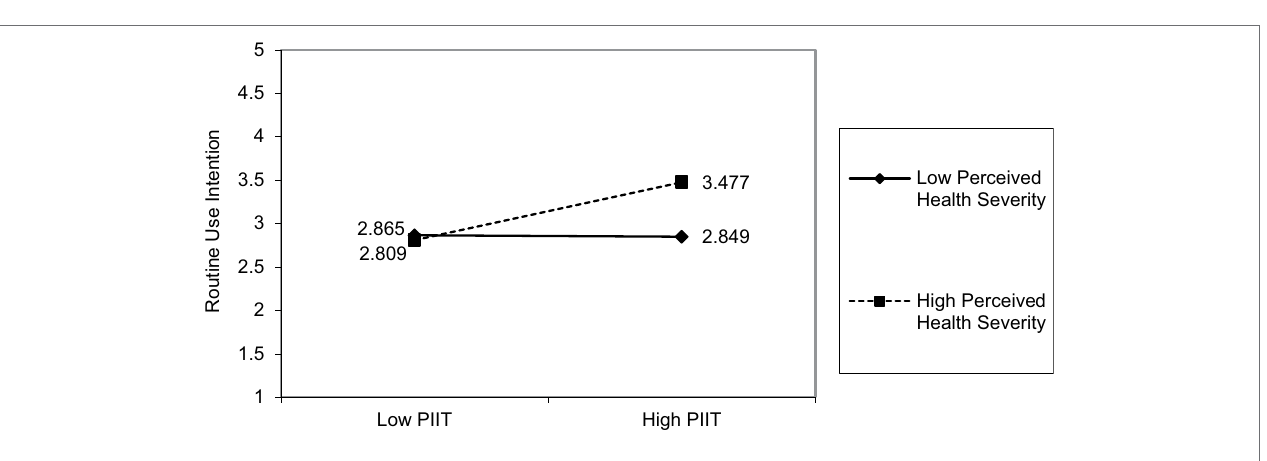
FIGURE 4 | Effects of perceived health severity on the relationship between PIIT and routine use